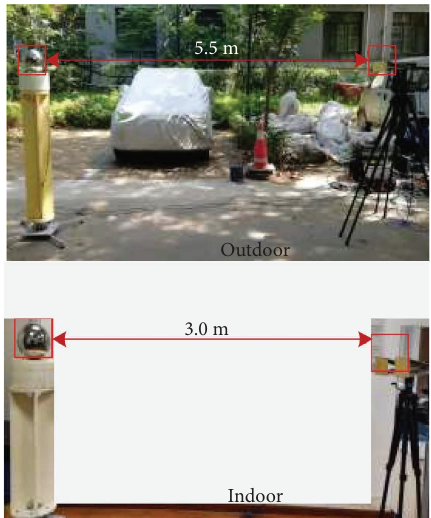
Figure 7: Calibration sphere time domain remote measurement chart.